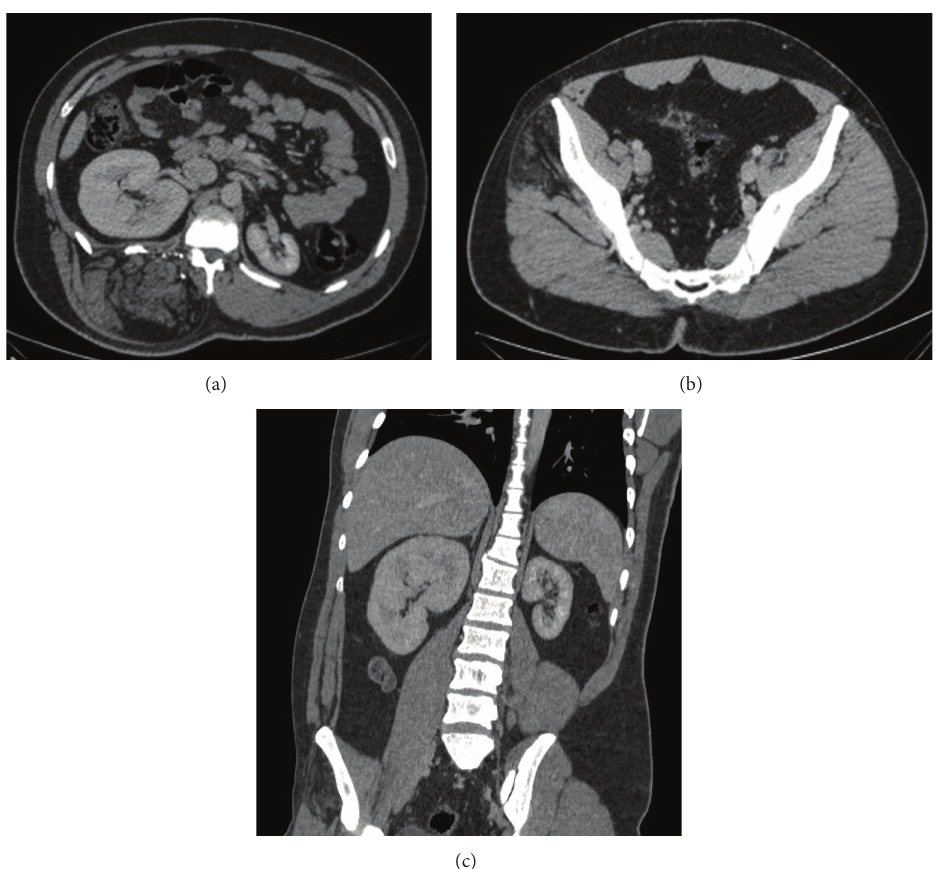
Figure 2: A 21-year-old man with Proteus syndrome presenting asymmetric lower limbs and epidermal nevus. CT of the abdomen showed tissue with a fat density infiltrating the right paraspinal musculature, with increased local volume extending from T7 to L5, in addition to an enlargement of the right kidney (a). The scan also noted fatty replacement in right gluteal muscles (b). Coronal CT showed asymmetry of the kidneys